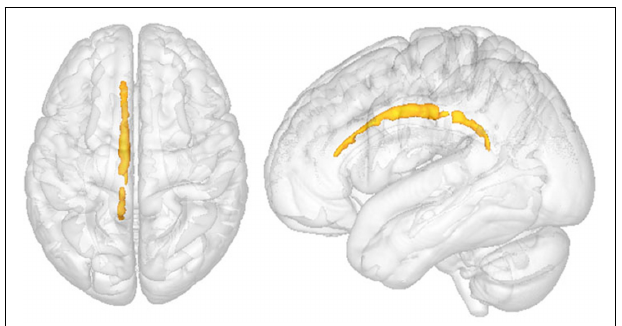
FIGURE 3 | Comparison between OCD patients and healthy controls in the left cingulate bundle (CB). Region of interest (ROI) analysis between groups. Clusters of voxels significantly different ( p < 0.05) are shown in red for fractional anisotropy (FA) in the white matter (WM). p =